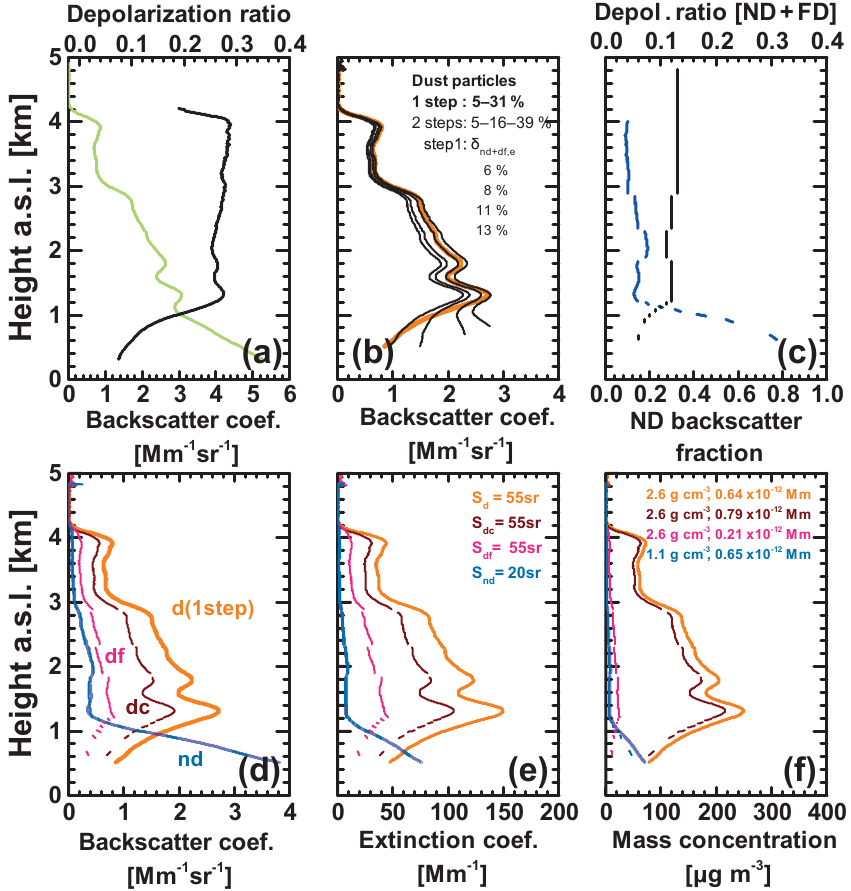
Figure 10. Lidar products (dust and non-dust backscatter, extinction and mass concentrations in panels d , e , and f ) obtained from the combined use of the one-step and the two-step POLIPHON method. In (a) , the measured 532nm particle backscatter coefficient (green) and particle linear depolarization ratio (black, as in Figs. 7 and 9) are shown. In (b) , the dust backscatter profile obtained with the one-step method (thick orange) is compared with four profiles of the total (fine + coarse) dust backscatter coefficients derived with the two-step method (thin black lines) by assuming height-independent depolarization ratios, δ dn + df (for non-dust + fine dust aerosol), of 6, 8, 11, and 13% and a value for δ dc of 39% for coarse dust in the first round and depolarization ratios of δ nd of 5% (non-dust) and δ df of 16% (fine dust) in the second round of the two-step retrieval. In (c) , the vertical distribution of the optimum δ dn + df (black profile segments), for which the profiles of the dust backscatter coefficients obtained with one-step and two-step methods match within ± 0.05Mm − 1 sr − 1 , is shown. In addition, the corresponding profile of the non-dust-to-total particle backscatter ratio (ND backscatter fraction, blue profile segments) is presented. In (d) , the retrieved backscatter coefficients are shown, separately for fine dust (df, pink), coarse dust (dc, dark red), total dust (d(1-step), orange, one-step method), and the non-dust aerosol (nd, blue, two profiles, one-step and two-step approaches). In (e) , the respective dust and non-dust extinction coefficients are shown. They are obtained by multiplying the backscatter coefficients (in d ) with the lidar ratio of 55sr (dust) and 20sr (marine). In (f) , the total, fine, and coarse dust and marine particle mass concentrations are given, derived from the extinction profiles (in e ) by using the conversion factors in Tables 2 and 3. The conversion factors are listed as numbers together with the assumed particle densities in panel (f)